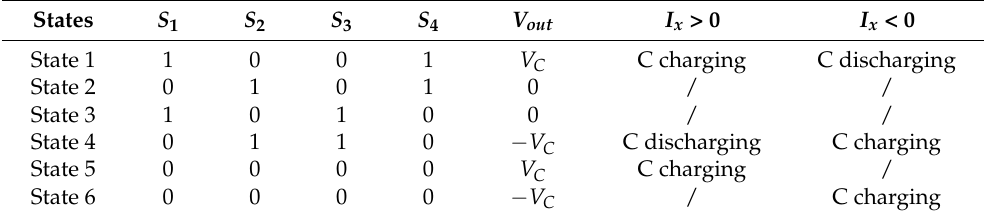
Table 3. FB-SM switching states